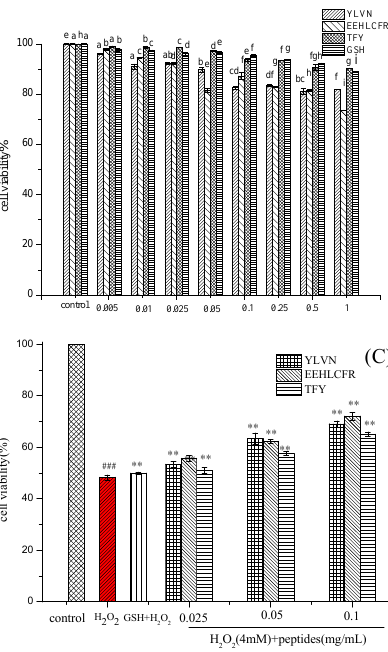
(D) Figure 8. Effects of different peptide concentration treatments on H 2 O 2 -stressed cells. The ROS levels ( A ), GSH-Px ( B ), CAT ( C ) and SOD ( D ). ### p < 0.001 versus the control group; ** p < 0.01 versus the H2O2-induced group.